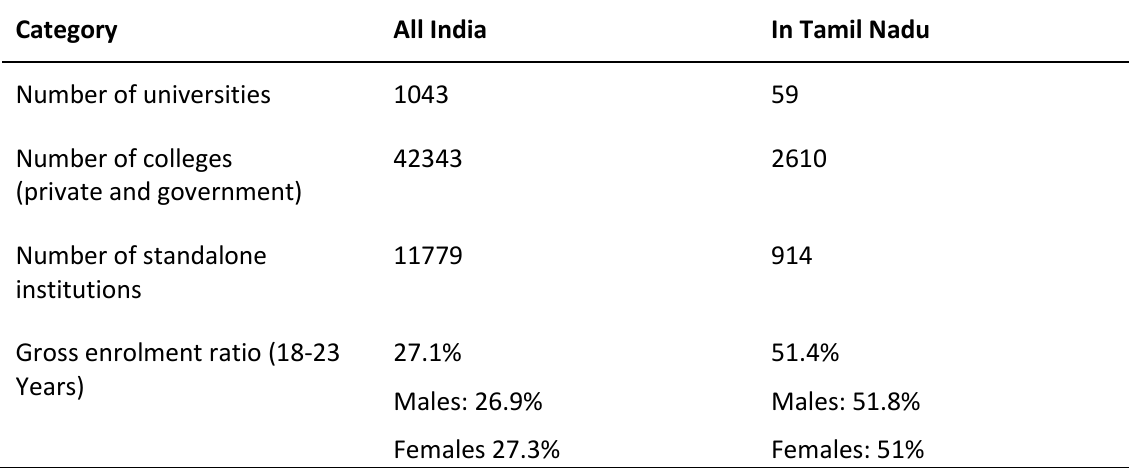
Statistics of Higher Education Institutions. Data correlated from All India Survey on